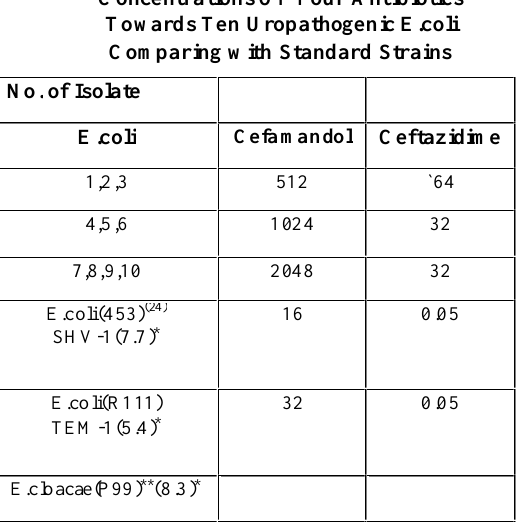
Minimum inhibitory concentrations